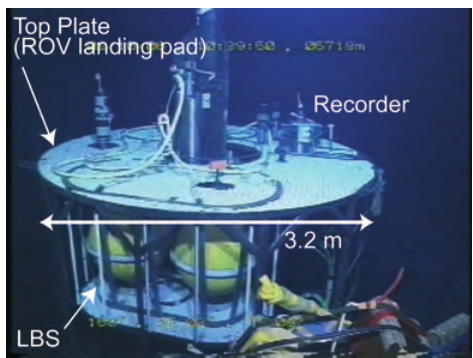
Fig. 5. An ROV view of the WP-1 station after the maintenance of the system (October 6, 2002). The power is supplied from lithium batteries in the titani- um spheres (Lithium Battery System unit). Top of the battery frame is also used as an ROV landing pad. The data recorder package can be seen on top of the battery/recorder unit.